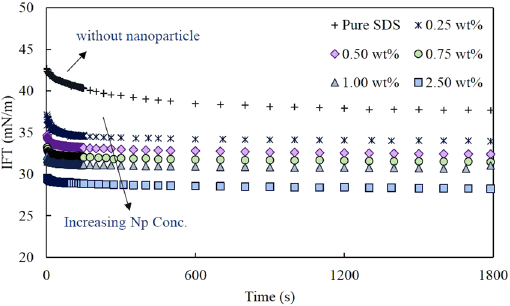
Figure 1. Dynamic interfacial tension of n-heptane/SDS solutions in the presence of different amounts of nanoparticles (Levasil 300/30, 9 nm). The surfactant concentration was fixed at 4.1 × 10 − 1 mM (0.05 CMC) in all experiments. The average error for each experiment is less than 0.5